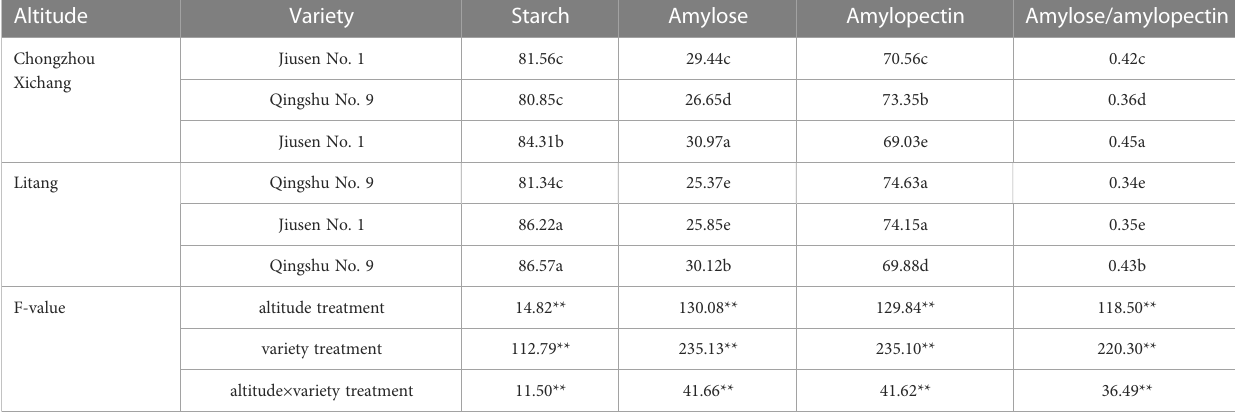
TABLE 2 Variance analysis of the content (%) and proportion of potato starch, amylose and amylopectin of potato varieties at different experimental site. Altitude